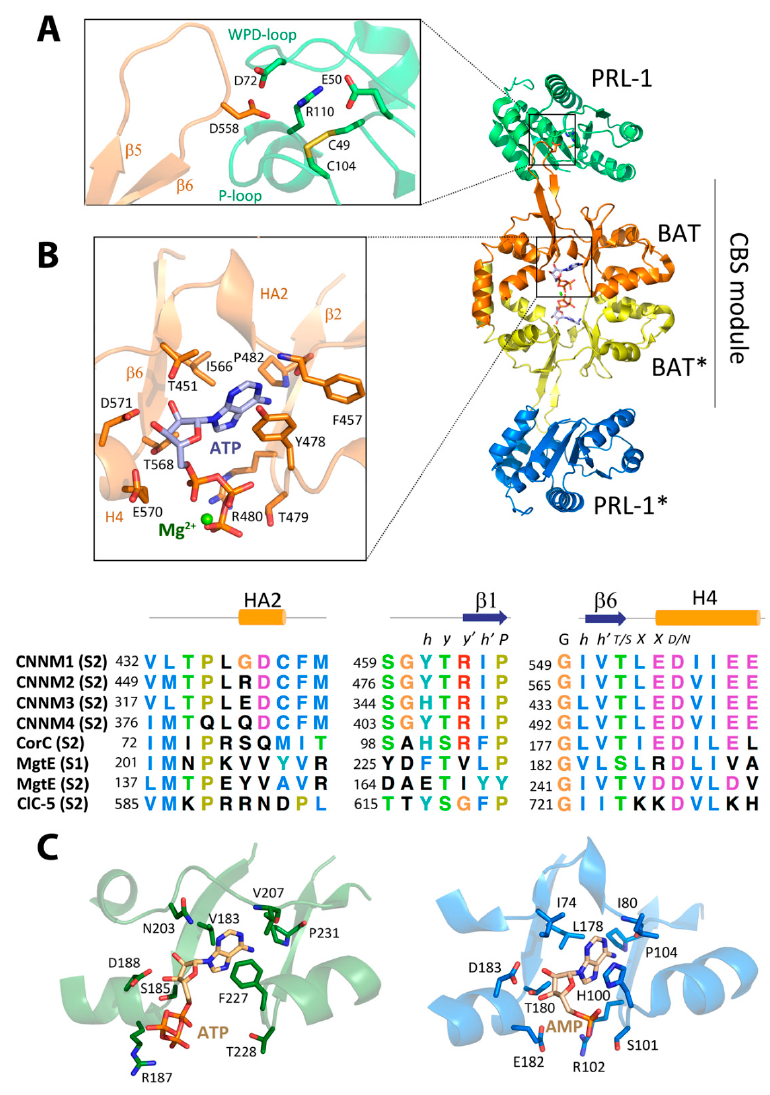
Figure 3. Structure of the CNNM-PRL complex. The picture shows the crystal structure of the CBS module of CNNM2 (PDB code: 5LXQ) (the two Bateman modules are in yellow and orange) in complex with PRL-1 (in green and blue). As shown, the CBS module adopts a flat conformation. MgATP (in sticks) occupies the complementary S2 cavities. ( A ) Detail of the main interactions between CNNM2 and PRL-1. D558 from CNNM2 (orange) enters the catalytic cavity of PRL-1 (green); ( B ) MgATP-binding site (cavity S2) in CNNM2. The main residues involved in the interaction with ATP are represented in sticks. ( Bottom ) Sequence alignment of the three main blocks forming the walls of the S2 site. The conserved motif h y y’ h’ P (where h is hydrophobic, y is whatever, and P is proline) stabilizes the adenine ring and favors the presence of adenine-derived nucleotides. Conserved T568 and D571 interact with the hydroxyl group of the ribose ring and belong to the conserved motif G h h’ T/S X X D/N (where h is hydrophobic, and X is any residue). The electrostatic repulsion exerted by residues E570, D571, and E572 is partially neutralized by Mg 2+ . Nucleotides bind to Site 2 (S2) in CNNMs, CorC, and ClCs, whereas MgtE binds ATP in Site 1 (S1). However, as shown in the alignment, conserved motifs are also present in S1 of MgTE. ( C ) Nucleotide-binding sites in MgtE and CorC (adapted from Tomita et al., 2017). ( left ) Site S1 of MgtE (represented in green), ATP is represented by sticks (PDB code: 5X9G). The conserved threonine of the G h h’ T/S X X D/N motif is substituted by a serine, and the conserved glutamate (E570 in CNNM2) is substituted by an arginine that interacts with the triphosphate chain of the ATP. The hydrophobic environment that stabilizes the position of the adenine ring is also present (motif h y y’ h’ P ) . ( right ) Site S2 of CorC (blue) bound to AMP (PDB code: 5YZ2) [69].